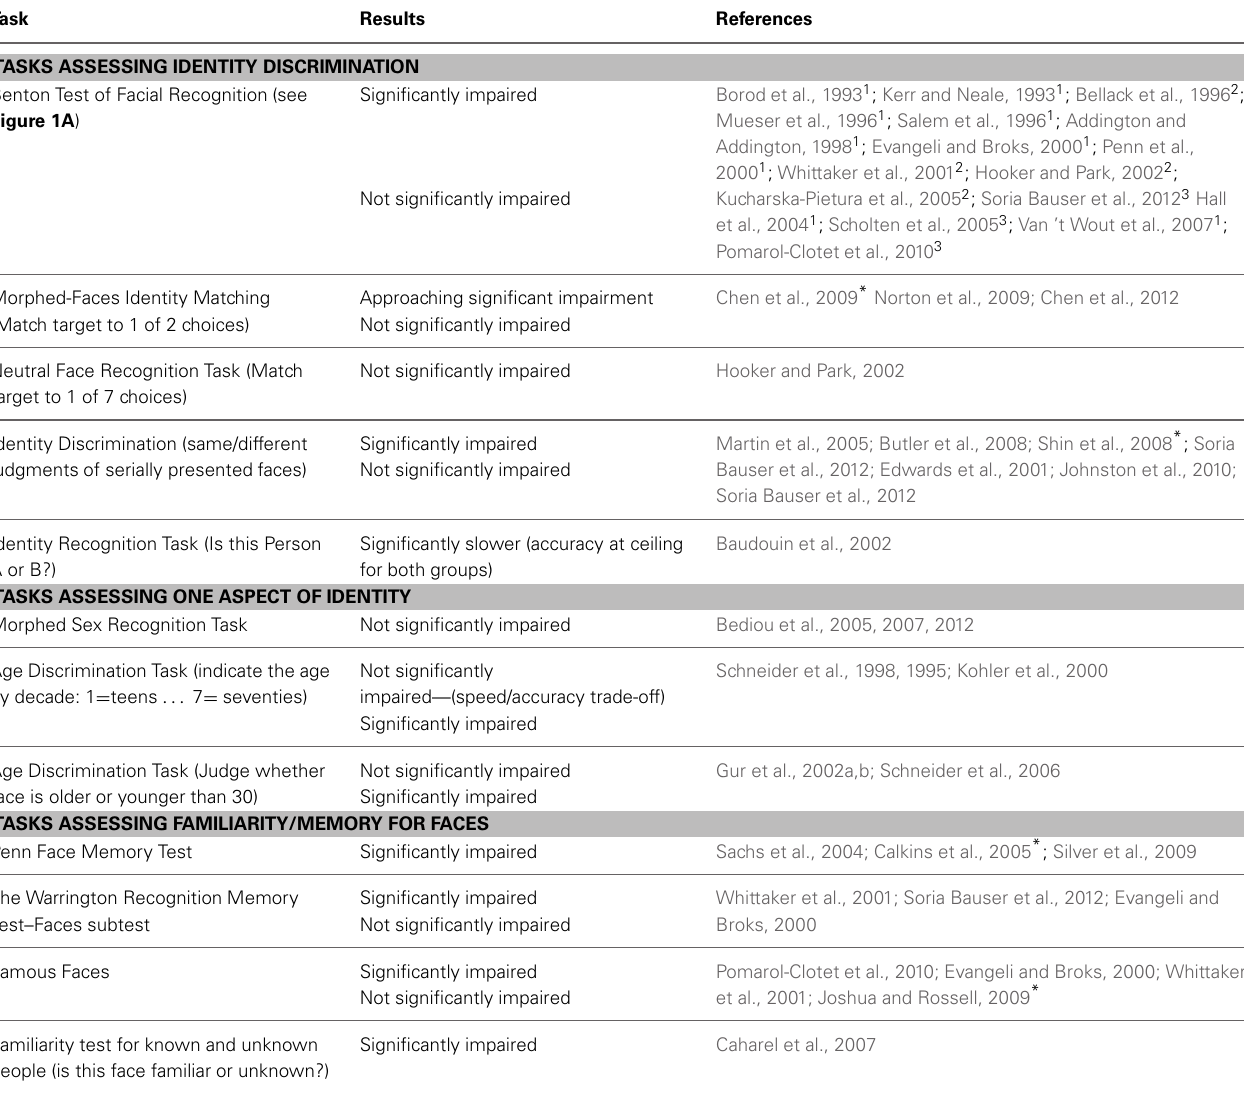
Table 1 | Identity recognition tasks used in schizophrenia research from the last 20 years—All results relate to performance of Schizophrenia patients relative to